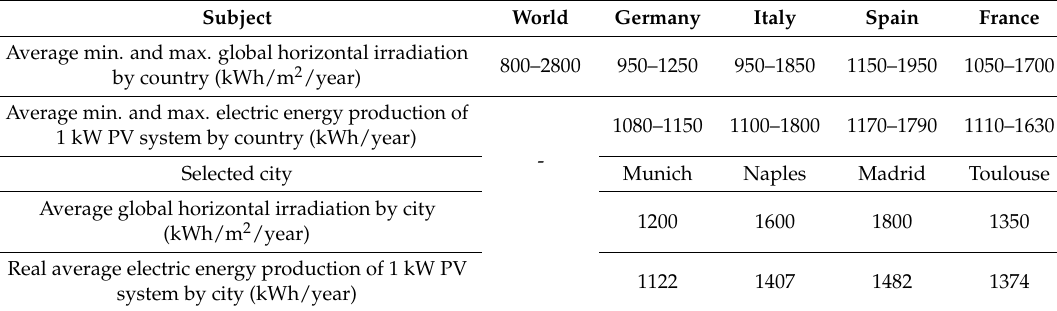
Table 1. Data of global horizontal irradiation (GHI) and electric energy production in the studied countries [43,45–49].